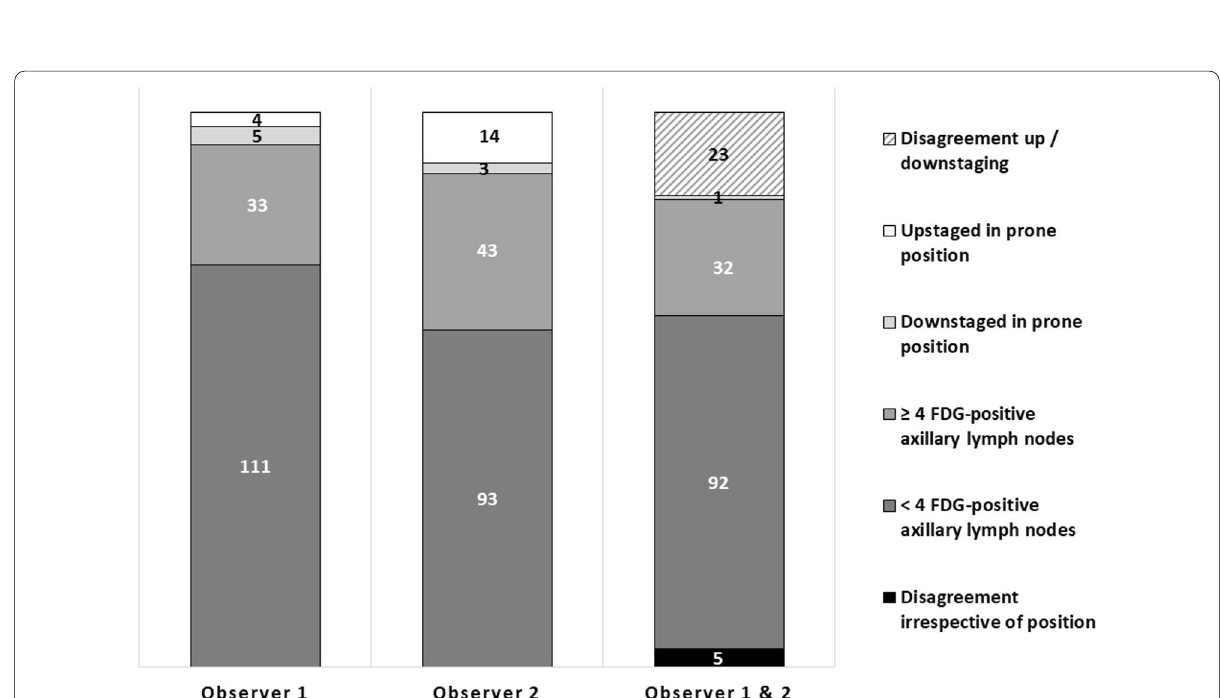
Fig. 3 Up‑ and downstaging of the axilla with [ 18 F]FDG‑PET/CT in prone compared to supine position. Observers disagreed on up‑/downstaging with prone FDG‑PET/CT in 23 patients and agreed 1 patient, who was downstaged. Observers agreed on staging irrespective of scan position in 124 patients: 32 had more than four (stage cALN 4) FDG‑avid axillary lymph nodes and 92 had less than four (stage cALN<4) FDG‑avid axillary nodes. ≥ Observers disagreed irrespective of scan position in 5